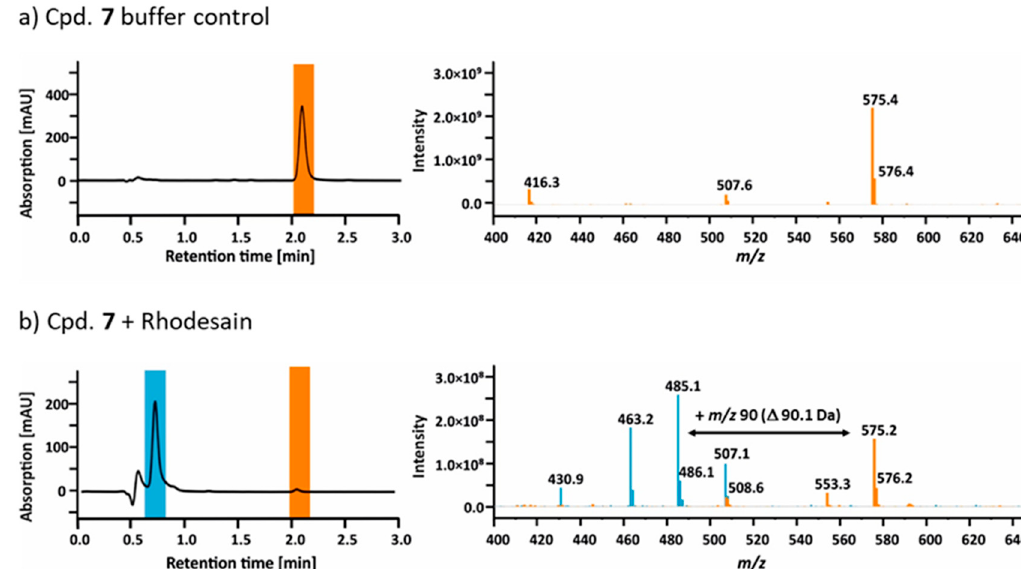
Figure 5. Chromatograms and mass spectra of the LC–MS runs of compound 7 preincubated with ( a ) buffer or ( b ) buffer and catalytically active rhodesain. The elution peaks and mass signals of the unconverted ester 7 are presented in orange, the signals of the resulting acid 8 are highlighted in blue.